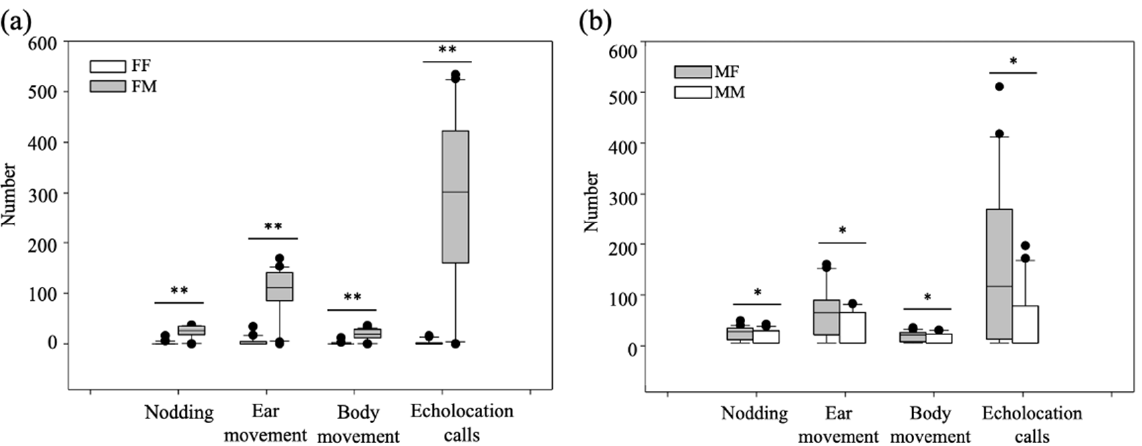
Figure 6. Results of the echolocation call sex recognition habituation-dishabituation playback ex- periment for Rhinolophus ferrumequinum . ( a ) The habituation sound wave is female and ( b ) the habituation sound wave is male. F represents female playback files, M represents male playback files, FF represents a change from female habituation sound waves to female dishabituation sound waves; FM represents a change from female habituation sound waves to male dishabituation sound waves; MF represents a change from male habituation sound waves to female dishabituation sound waves; and MM represents a change from male habituation sound waves to male dishabituation sound waves. * denotes p < 0.05, and ** denotes p < 0.01.